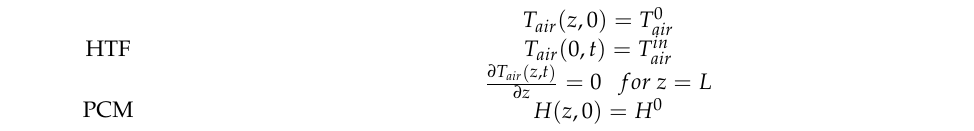
Figure 4. DSC Latent heat evaluation of the ternary PCM eutectic.